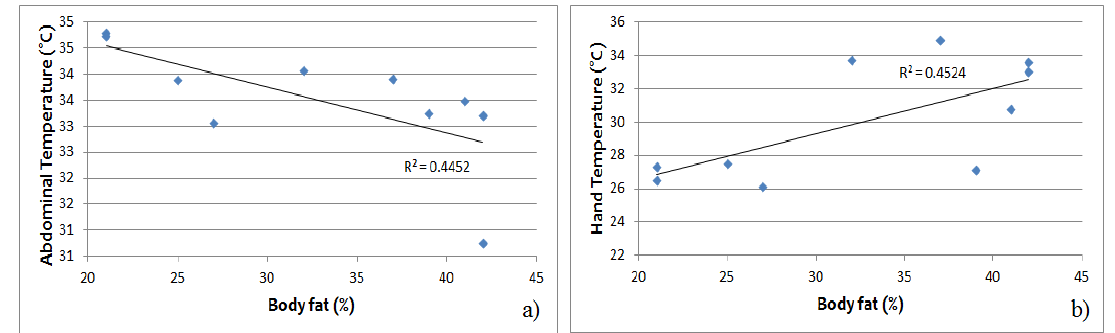
Figure 7. Baseline ( a ) abdominal and ( b ) hand temperature relative to the percentage of total body mass from fat in lean and overweight participants. The abdominal temperature is negatively related to body fat ( R 2 = 0.445, p < 0.05), while hand temperature is positively related to body fat ( R 2 = 0.452, p < 0.05).